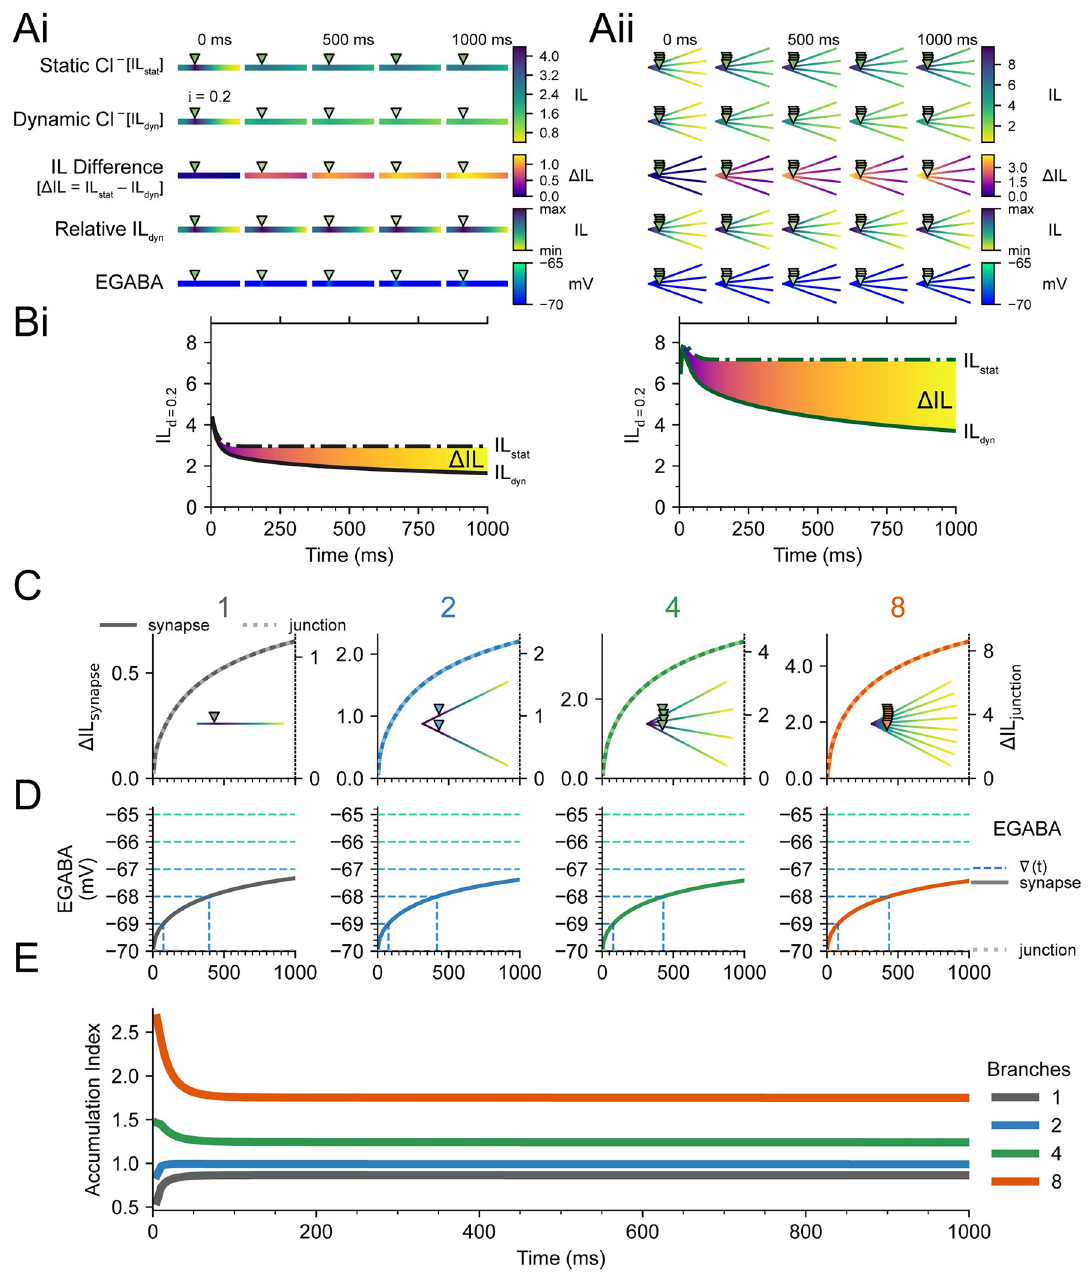
Fig 5. Chloride loading and shifts in EGABA progressively impact Inhibitory Level, but not Accumulation Index, over time. (A) IL and related properties calculated at different points in time (5, 250, 500, 750, and 1000 ms), with a backward time integration window, Δ t, of 5 ms. At 5 ms. A dendrite with a single branch, ‘Ai’, and a dendrite with four branches, ‘Aii’, is shown. IL with static Cl - (IL stat ), and IL with dynamic Cl - (IL dyn ), are identical. However, while IL stat reaches its steady-state by the next time point, IL dyn continues to decrease. Note that the heatmap is shared across time as well as IL with static or dynamic Cl - . The difference between IL stat and IL dyn , the IL Difference ( Δ IL), is strongly focused at the site of the inhibitory synapse but spreads throughout the dendrite over time even while changes in EGABA remain local. The relative IL dyn (IL dyn scaled between that dendrite’s minimum and maximum IL dyn ) indicates that although IL dyn changes over time, the changes are proportional. Initial r EGABA was -5 mV (EGABA = -70 mV, V m = -65 mV). (B) IL over a 1000 ms period for both a single-branch dendrite, ‘Bi’, and four-branch dendrite, ‘Bii’. With prolonged input (1000 ms), IL stat decreases until the membrane capacitance is charged and IL dyn stabilises when an equilibrium is reached between Cl - influx (via GABA A Rs) and efflux (via KCC2). (C) The Δ IL at the synapse (solid lines, left y-axes) and Δ IL at the junction (dotted lines, right y-axes) remain in proportion to each other over time, regardless of the number of branches in the dendrite. Note that the scales are different for each axis. These are location-specific traces of what is represented across the dendrite in “Relative